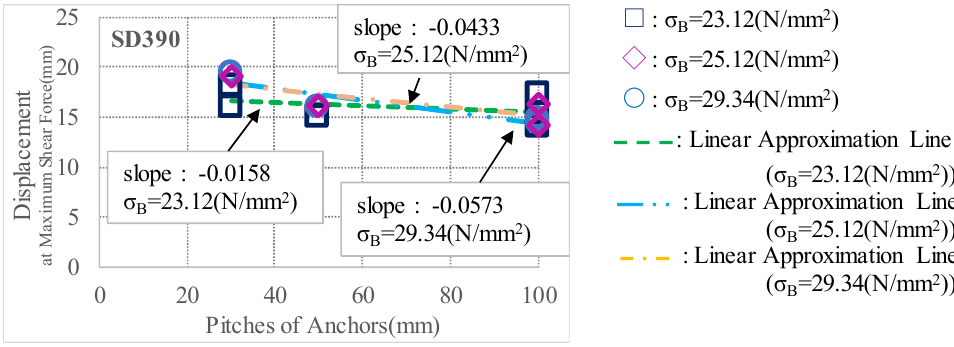
approximation lines with the compressive concrete strengths of 23.12, 25.12 and 29.34 (N/mm 2 ) were shown by a dotted, two-dot chain and one-dot